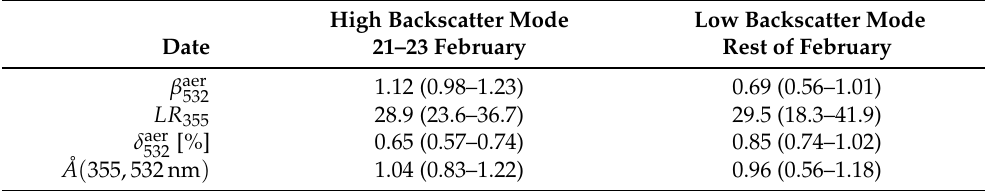
Table 2. Median of the retrieved optical parameters shown separately for the 3 days in February 2020 with the highest backscatter and for the rest of February. The 25th and 75th percentiles are indicated in the